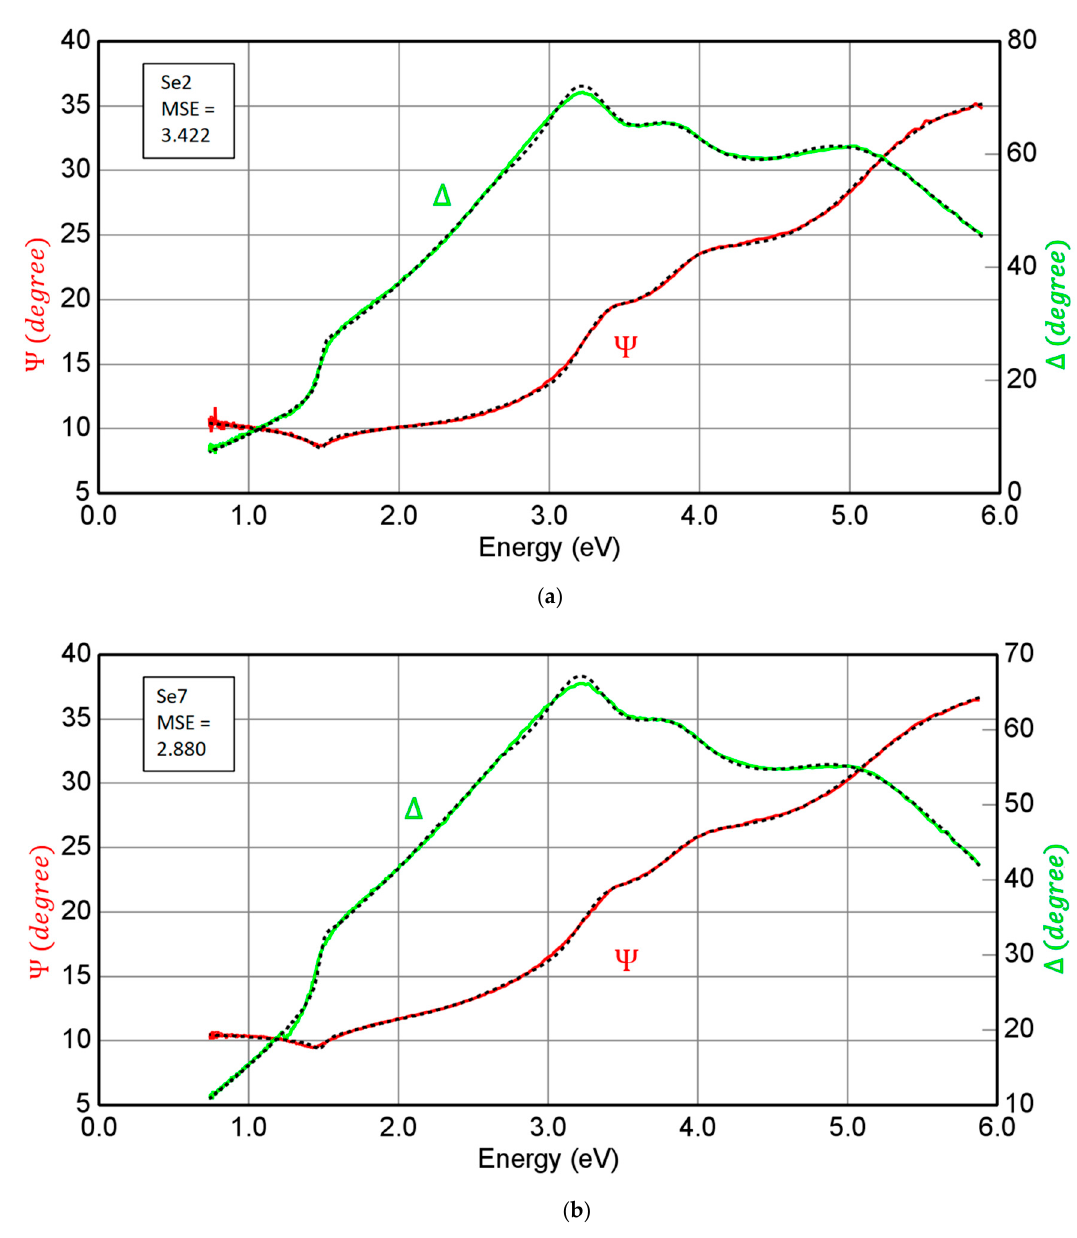
Figure 3. Evolution of the ellipsometric parameters Ψ and ∆ and the fit to the ellipsometry model proposed in Figure 1c for different selenium compositions ( a ) Se2 and ( b ) Se7. The lines represented by different colours are the experimental data, and the dashed lines correspond to the model.